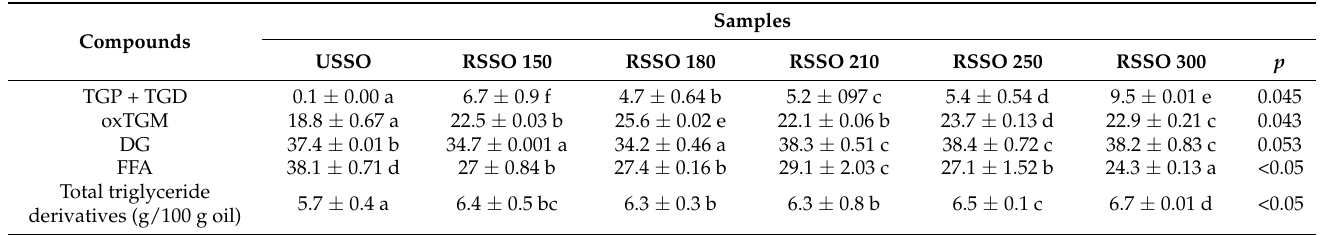
Table 3. Distribution of triglyceride derivatives expressed in relative % and total amount (g/100 g oil) in oils.